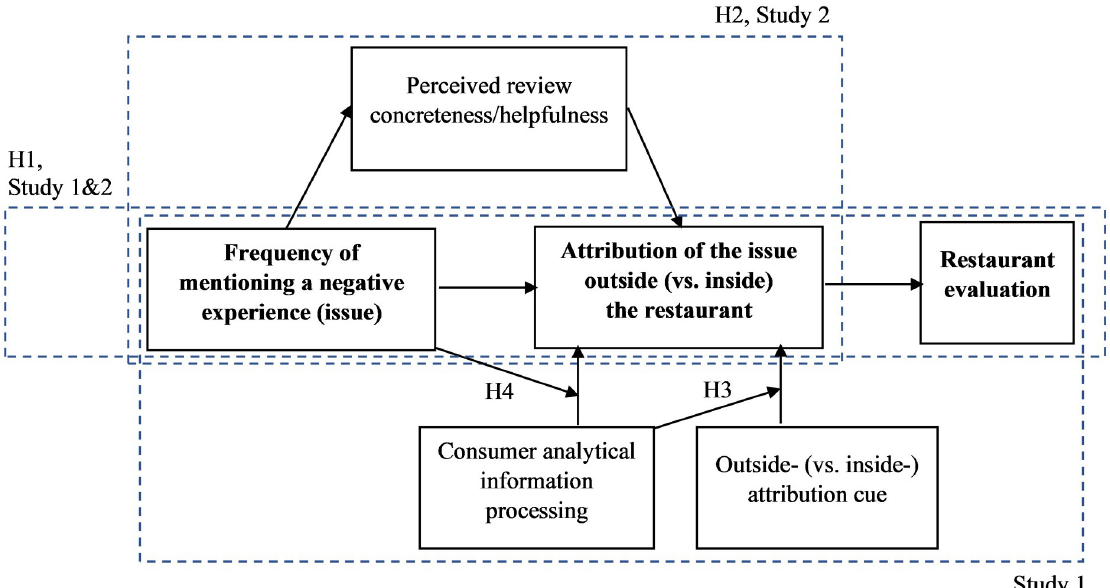
Fig 1. The conceptual